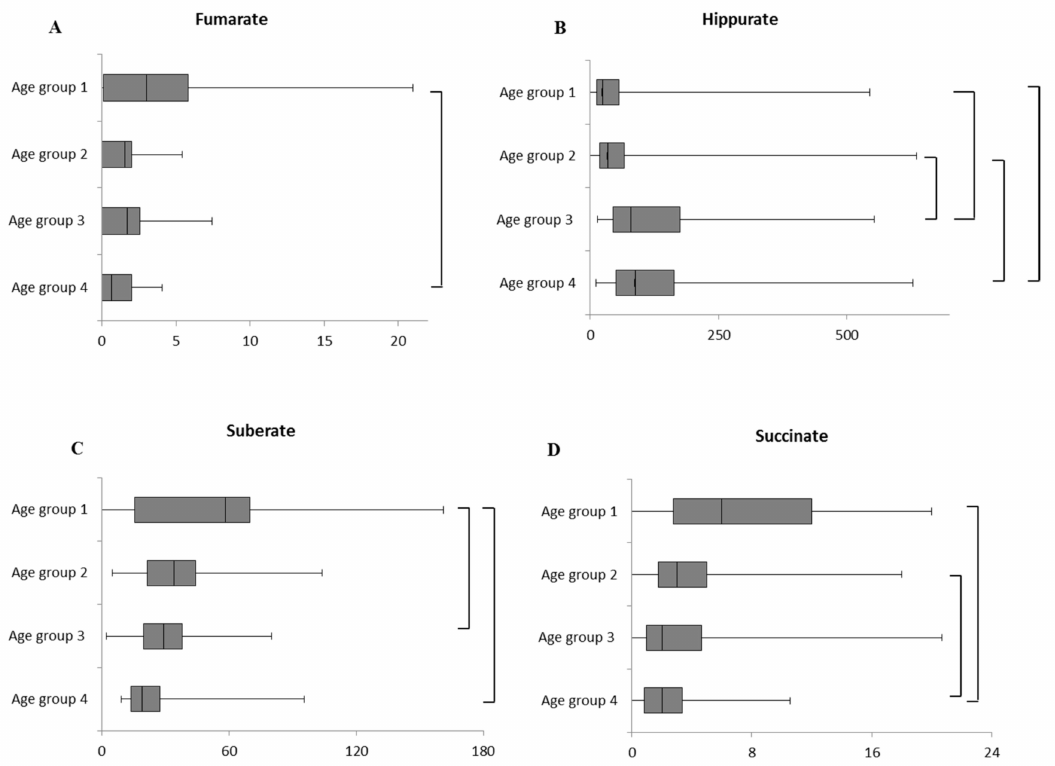
Figure 1. Box plot of age e ff ect on urinary ( A ) Fumarate, ( B ) Hippurate, ( C ) Suberate and ( D ) Succinate (mmol / mol creatinine) in male cohorts. The vertical line across the box represents the median, and the box comprises the first and the third quartiles. The horizontal lines represent the minimum and the maximum values. Sample size for each age group is reported in Table